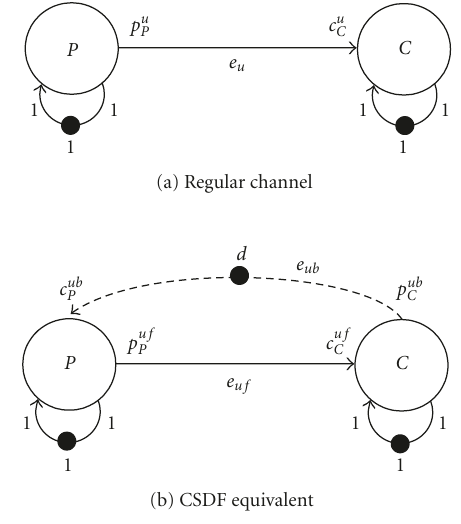
Figure 1: The feedback edge e ub limits the size of edge e u to d .